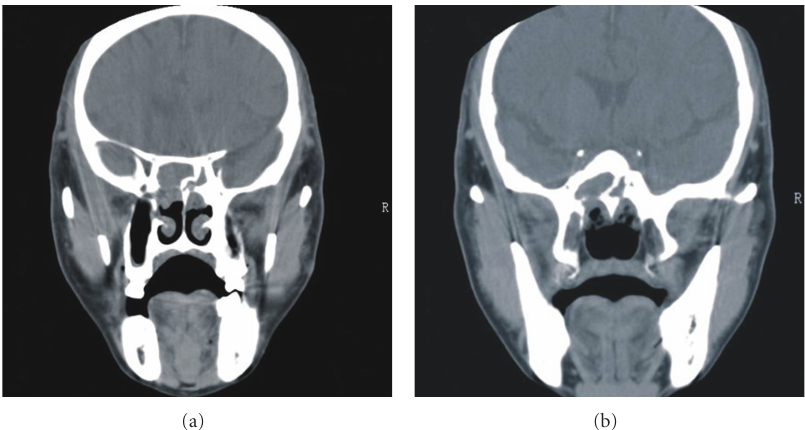
Figure 1: (a) Coronal computed tomography (CT) scan demonstrating edema in posterior ethmoid sinuses. (b) Coronal CT scan demonstrating soft masses in the bilateral sphenoid sinuses combined with bone absorption.